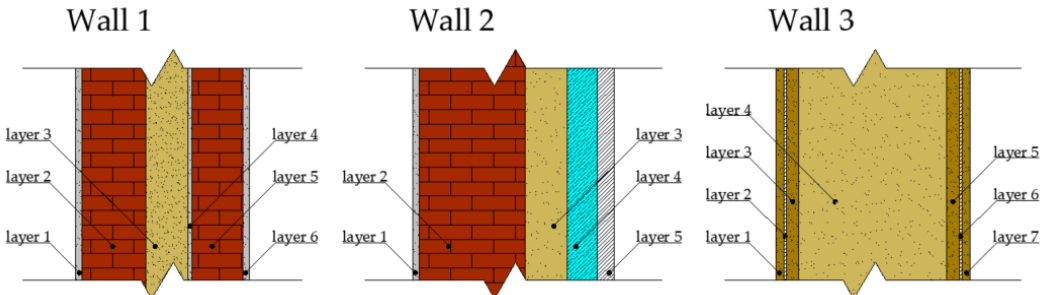
Figure 2. Italian climatic zones and related thermal-transmittance limits for external walls. Limits in